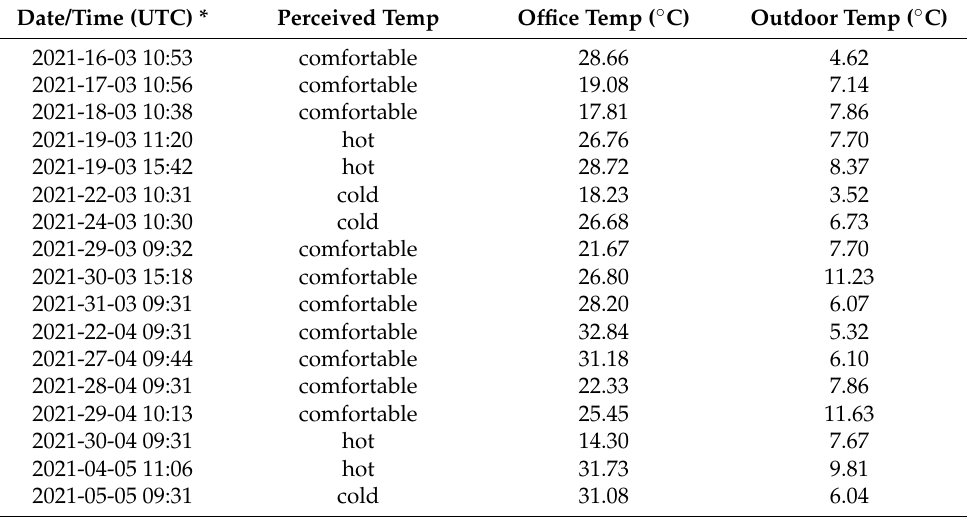
Table 2. Snapshot of participant’s perceptions towards temperature alongside indoor and outdoor measurements.